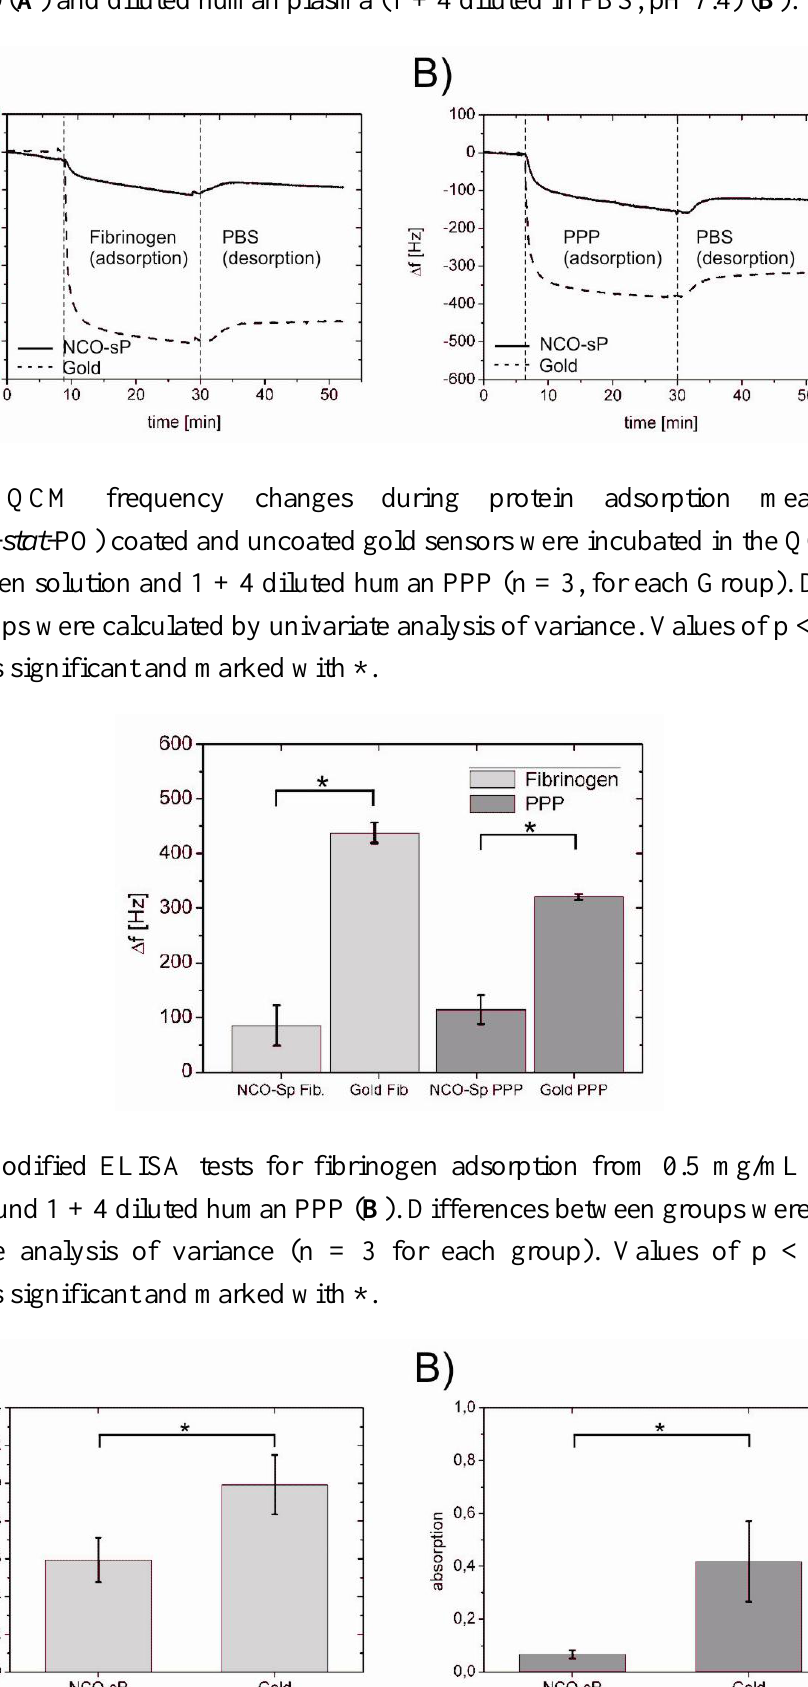
Figure 1. Protein adsorption measured by QCM with fibrinogen solution (0.5 mg/mL, in PBS, pH 7.4) ( A ) and diluted human plasma (1 + 4 diluted in PBS, pH 7.4) ( B ).